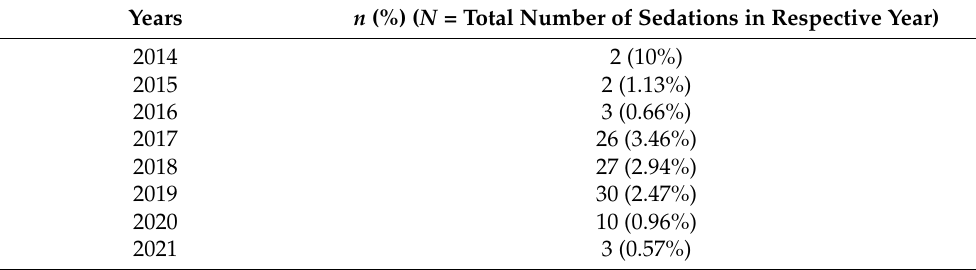
Table 13. Occurrence of adverse events per year from initiation